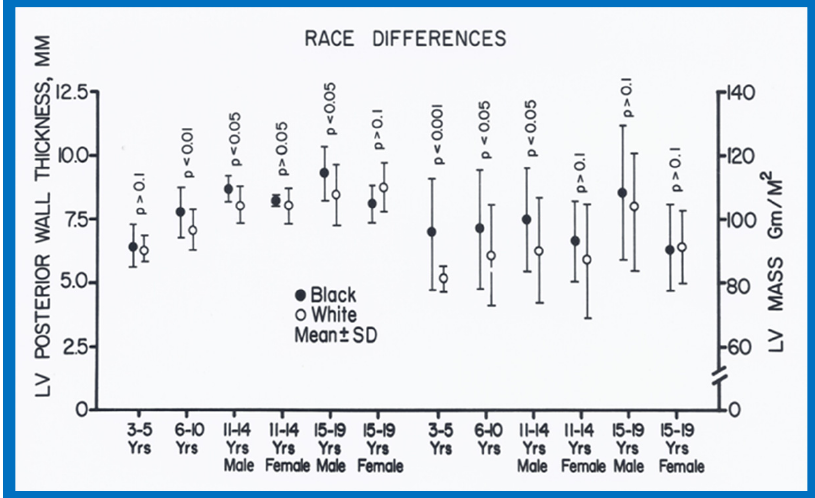
Figure 35. Race-related di ff erences in the measurements of left ventricular (LV) posterior wall thickness and LV mass are illustrated for black (filled circles) and white (unfilled circles) children. Means and standard deviations (SD) are shown. Note the larger ( p < 0.05 to < 0.001) LV posterior wall thickness and LV mass in black than white in all but 11-19 year-old females. Reproduced from Rao P.S., Thapar M.K. [10].